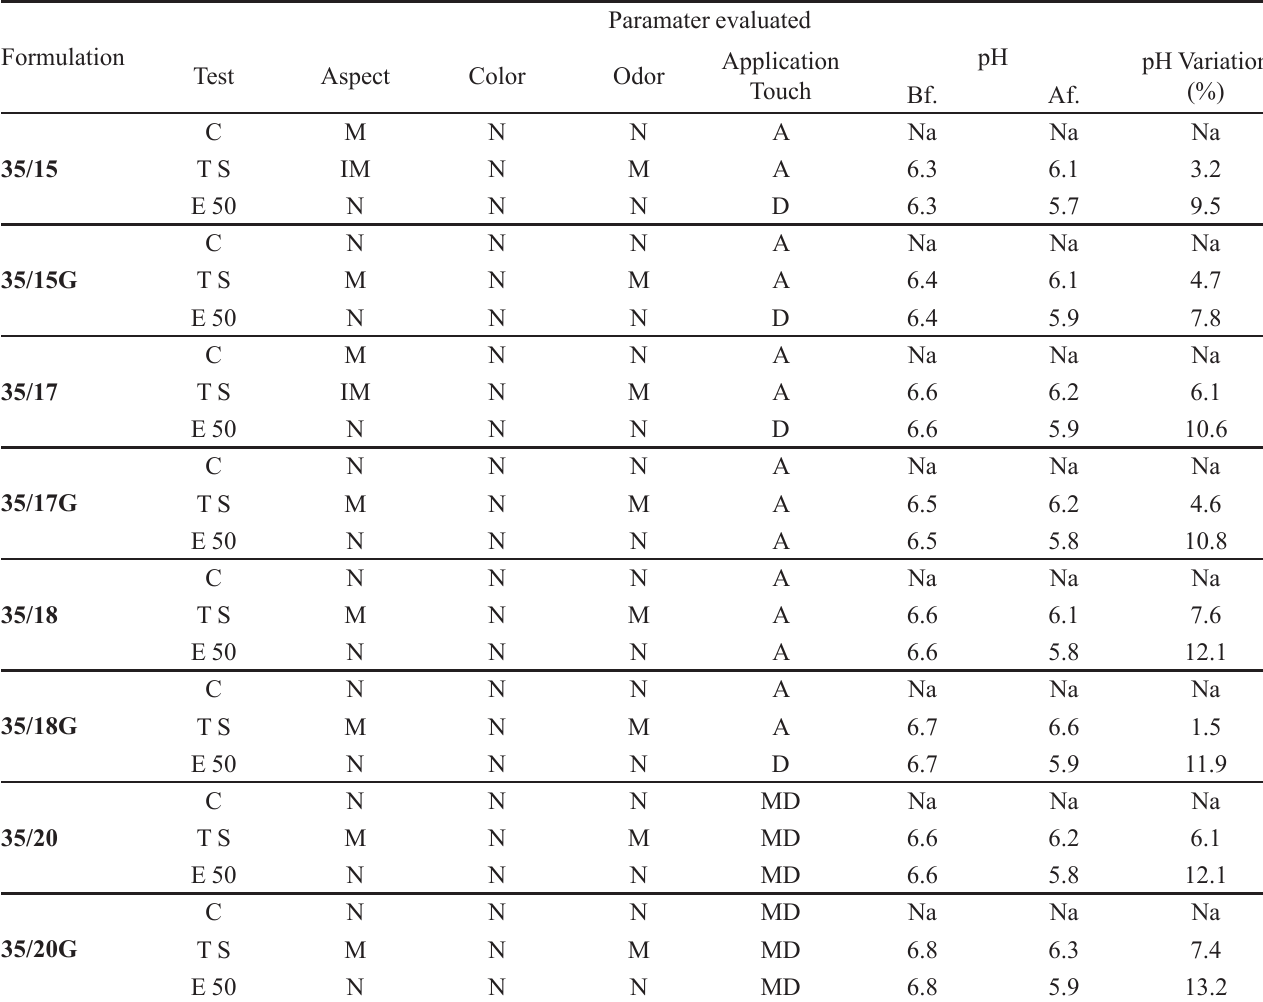
TABLE III - Organoleptic characteristics and pH values evaluation of the peel off facial mask formulations (modifications from the F35 base) in the Preliminary Stability Study